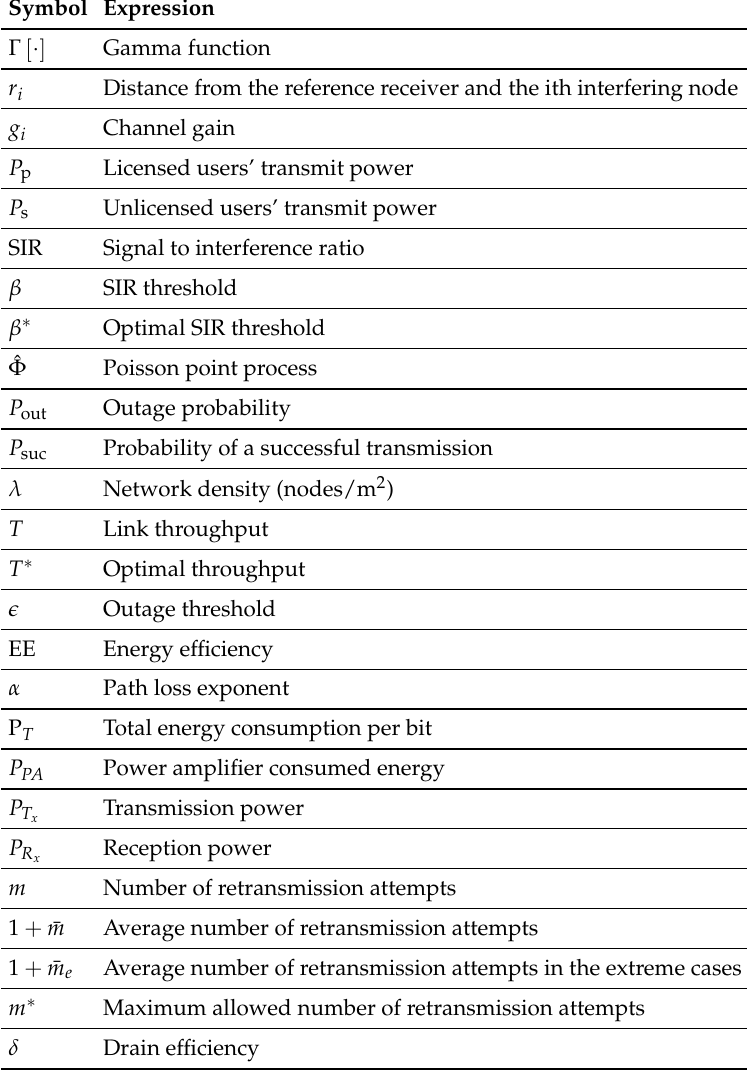
Table 1. Summary of the functions and